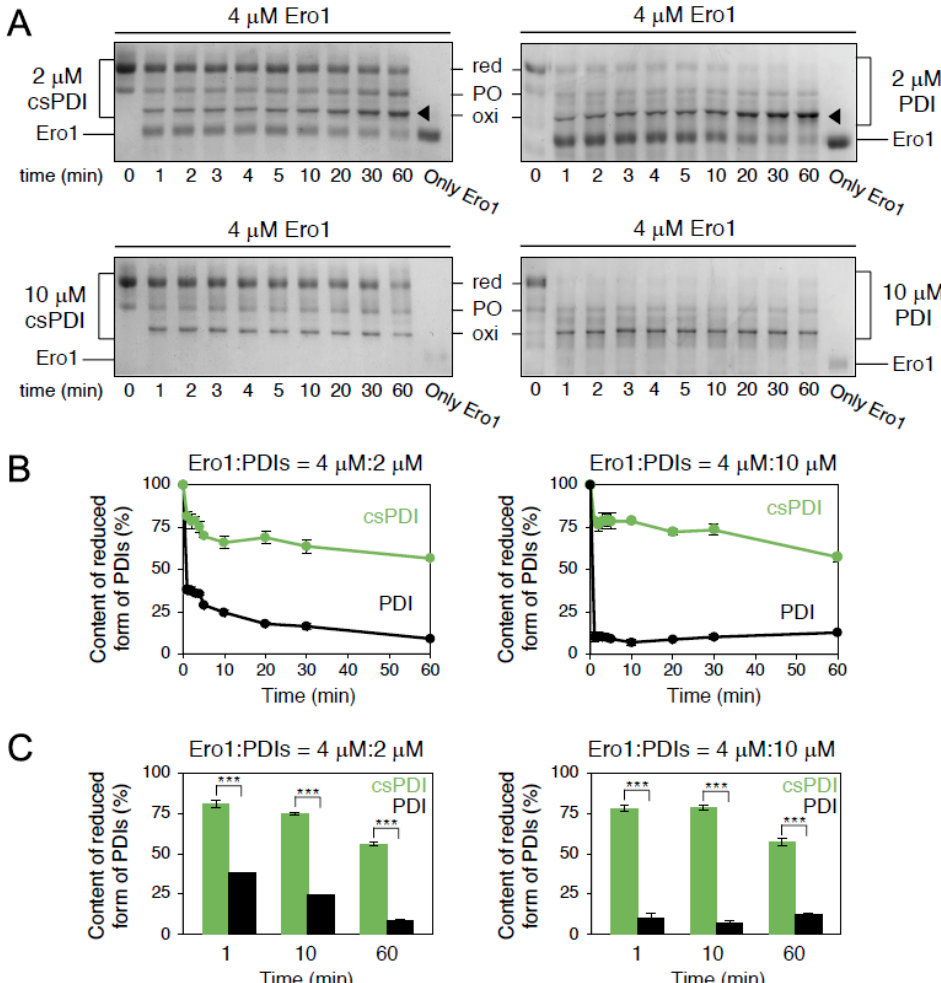
Figure 4. ( A ) Time course of the redox-state change of PDI or csPDI in the presence of Ero1. Experiments were performed by mixing the reduced form of PDI or csPDI (2 or 10 µ M each) with Ero1 (4 µ M) in air-saturated buffer at 30 ◦ C. At the indicated time points, reactions were quenched by adding maleimide-polyethylene glycol − 2k (1 mM). The redox states of PDI and csPDI were analyzed by non-reducing SDS-PAGE. red = reduced; oxi = oxidized; PO = partially oxidized; black arrow = reduced Ero1 co-migrating with oxidized PDI. ( B ) Quantification of the fraction of the reduced form of PDI or csPDI based on the gel data shown in A ( n = 3, means ± SD). ( C ) Quantification and statistical analyses of the fraction of the reduced form of csPDI or PDI at the indicated time points in B ( n = 3, means ± SD). *** p < 0.001.